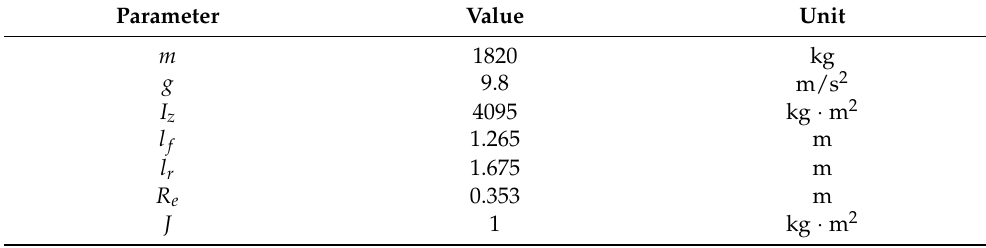
Table 1. Vehicle parameters.